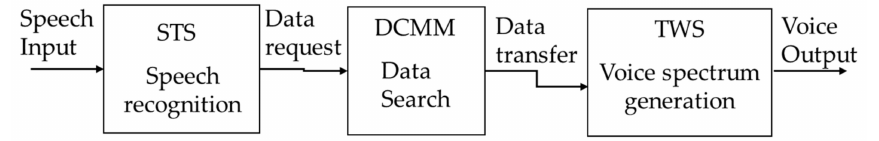
Figure 3. Structure and data flow of ACM.